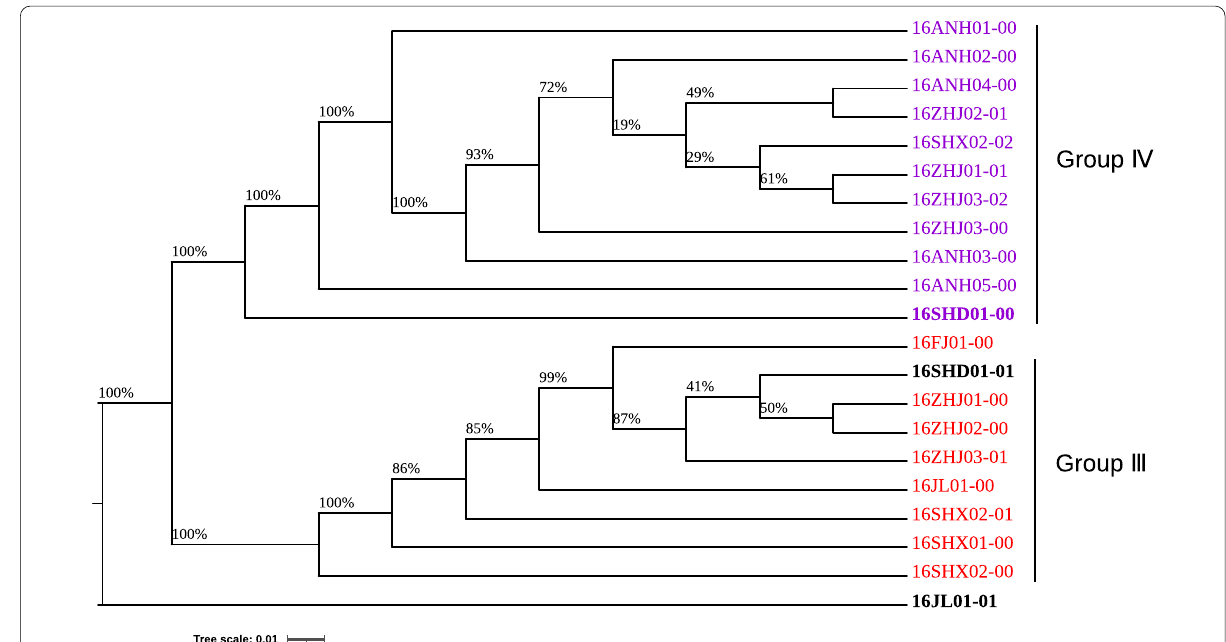
Fig. 5 Phylogenetic tree of 22 lingzhi strains based on SNP